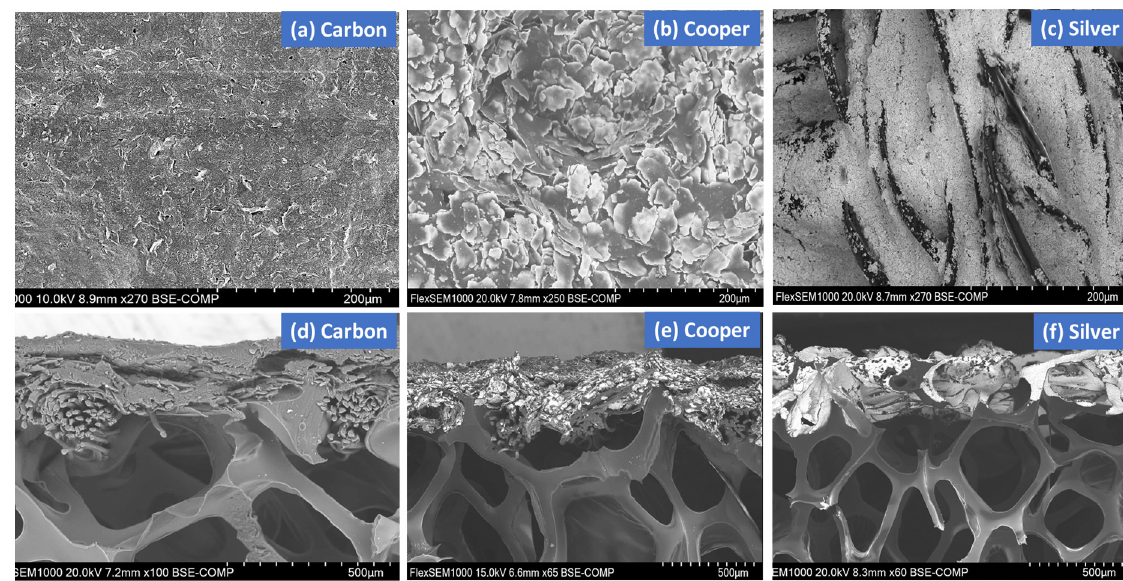
Figure 13. Micrographs of carbon, copper, and silver coatings for ( a – c ) the top view (taken on the top surface) and ( d – f ) the edge view (taken in the